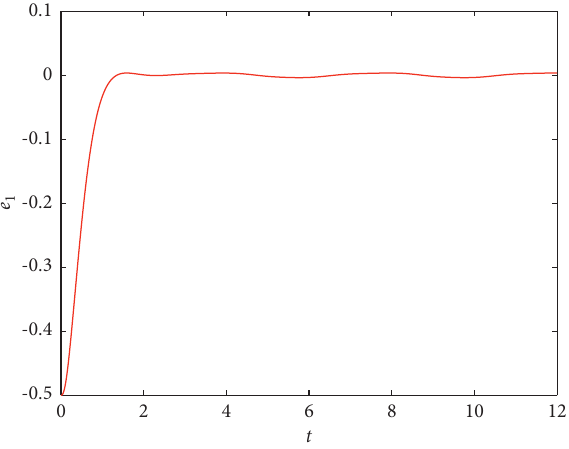
Figure 9: State error e